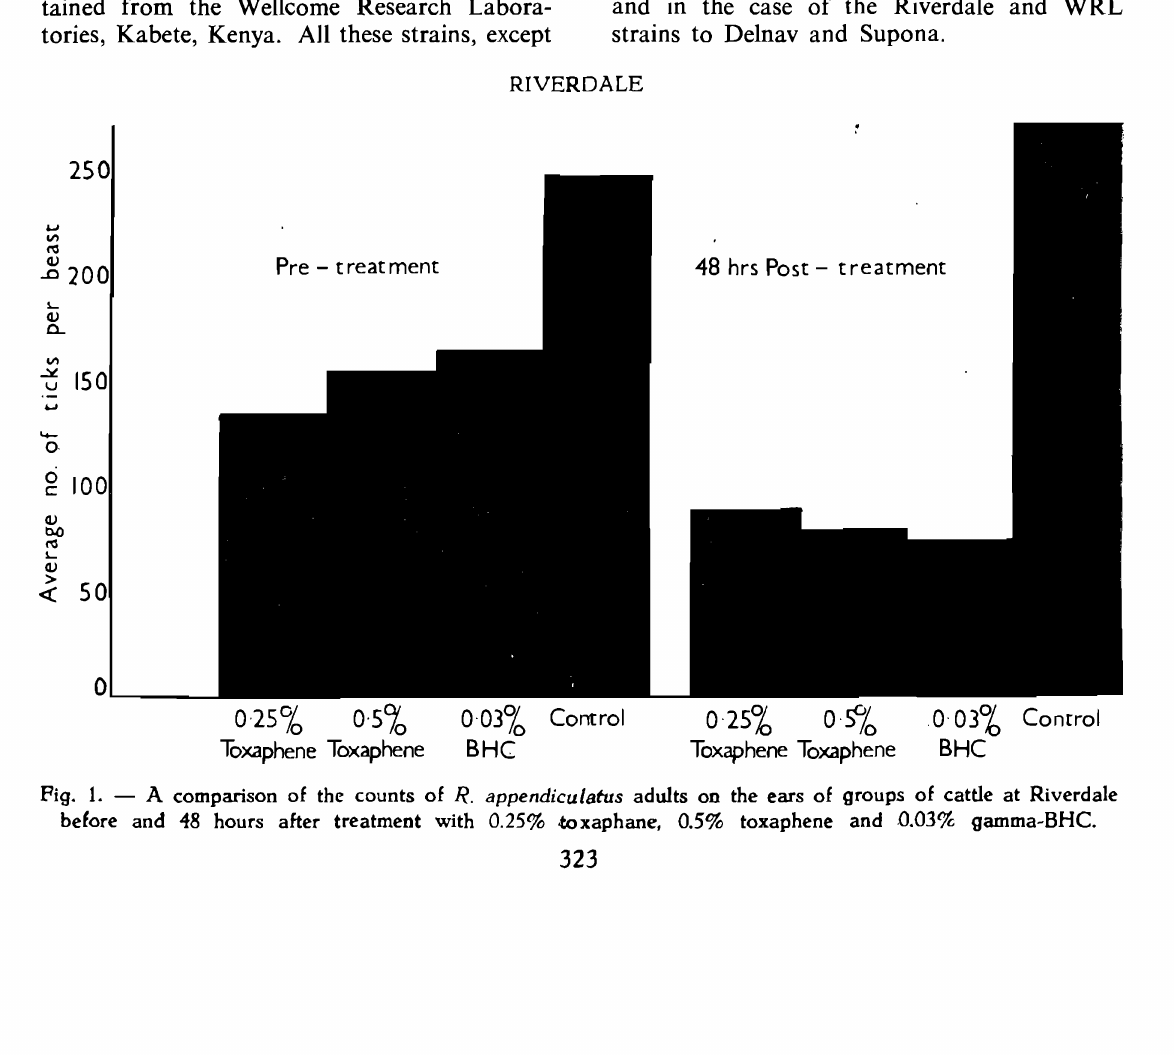
Fig. 1. - A comparison of the counts of R. appendiculstus adults on the ears of groups of cattle at Riverdale before and 48 hours after treatment with 0.25% -toxaphane. 0.5% toxaphene and 0.03%